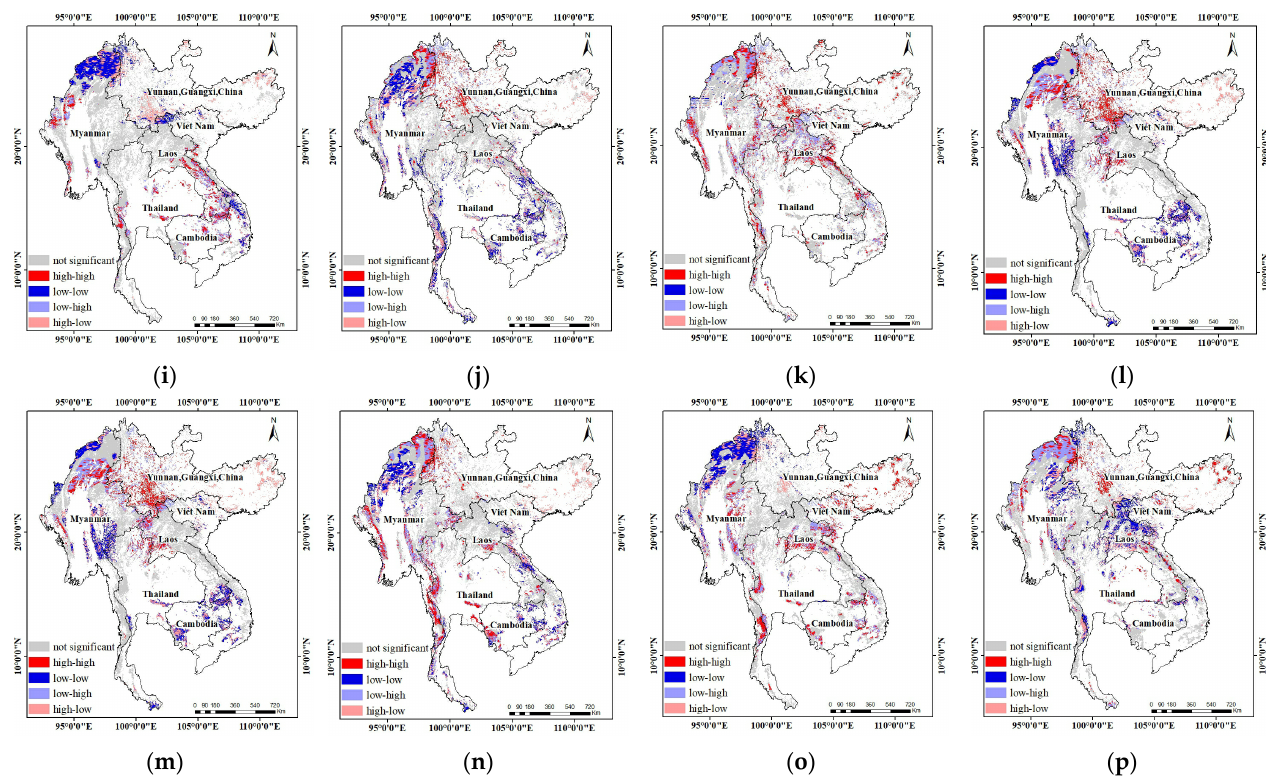
Figure 8. Spatial correlations in EVI with climate and environmental variables. ( a – p ) Spatial clustering maps of EVI with bio01, bio04, bio05, bio06, bio08, bio09, bio10, bio12, bio15, elevation, topographic slope, surface net solar radiation (SSR), surface solar radiation downward (SSRD), soil temperature layer 1 (STl1), volumetric soil water layer 1 (SWVl) and total evaporation, respectively.